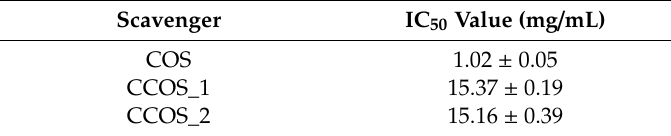
Figure 7. 2,2-diphenyl-1-picrylhydrazyl (DPPH) radical scavenging activity of some COSs. All data points were the mean and standard deviation. Table 4. The IC 50 value of DPPH radical scavenging activity of some COSs.